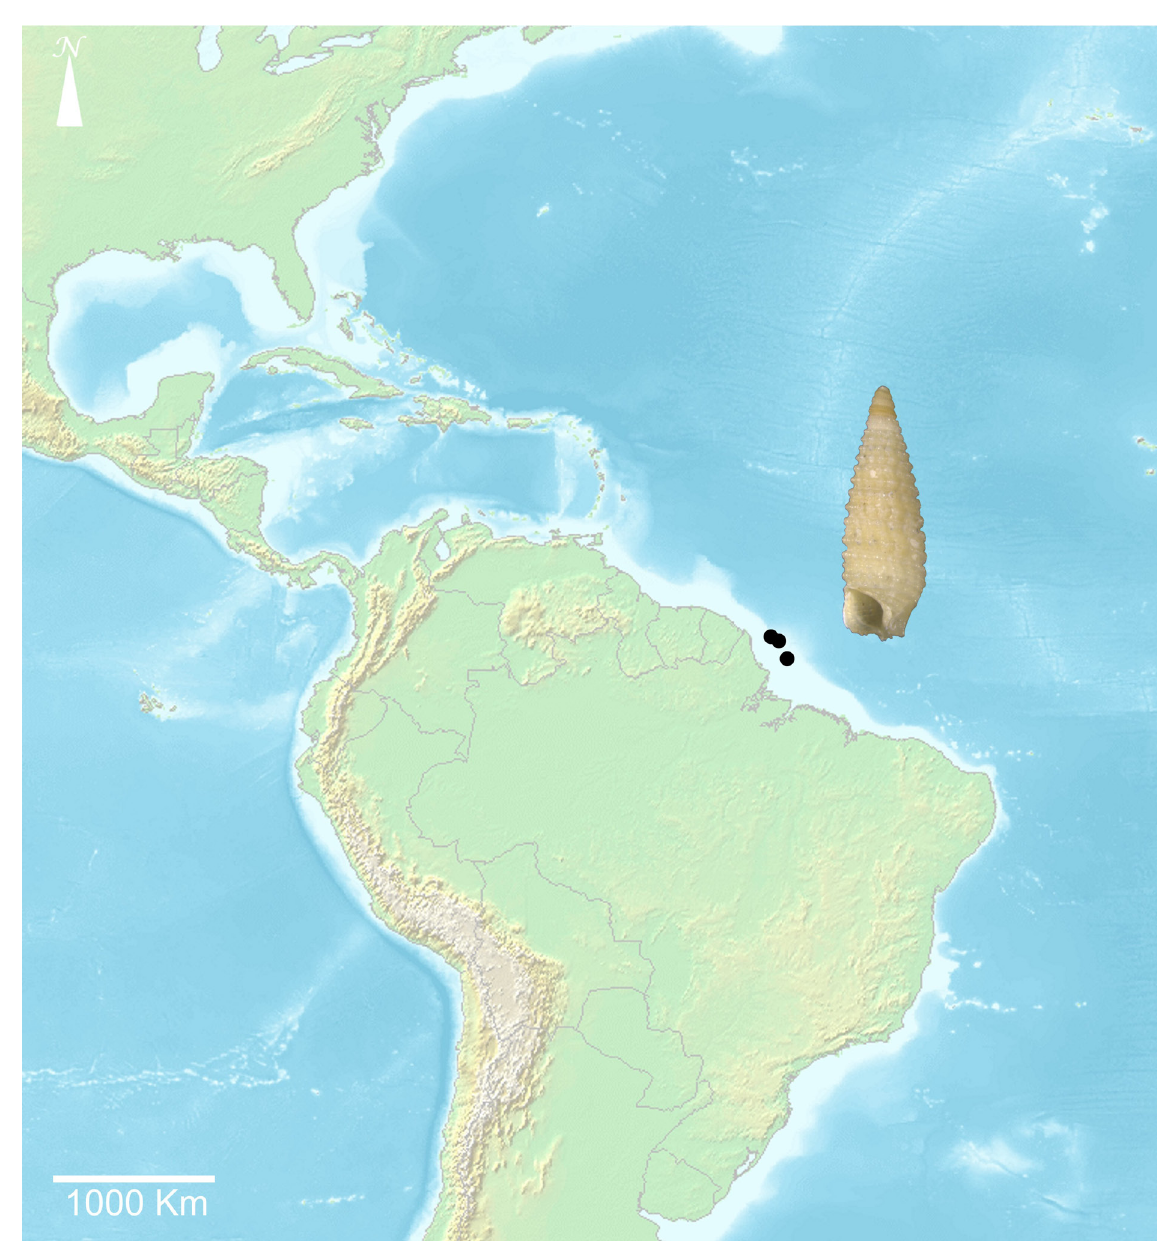
Fig. 63. Distribution map of Sagenotriphora